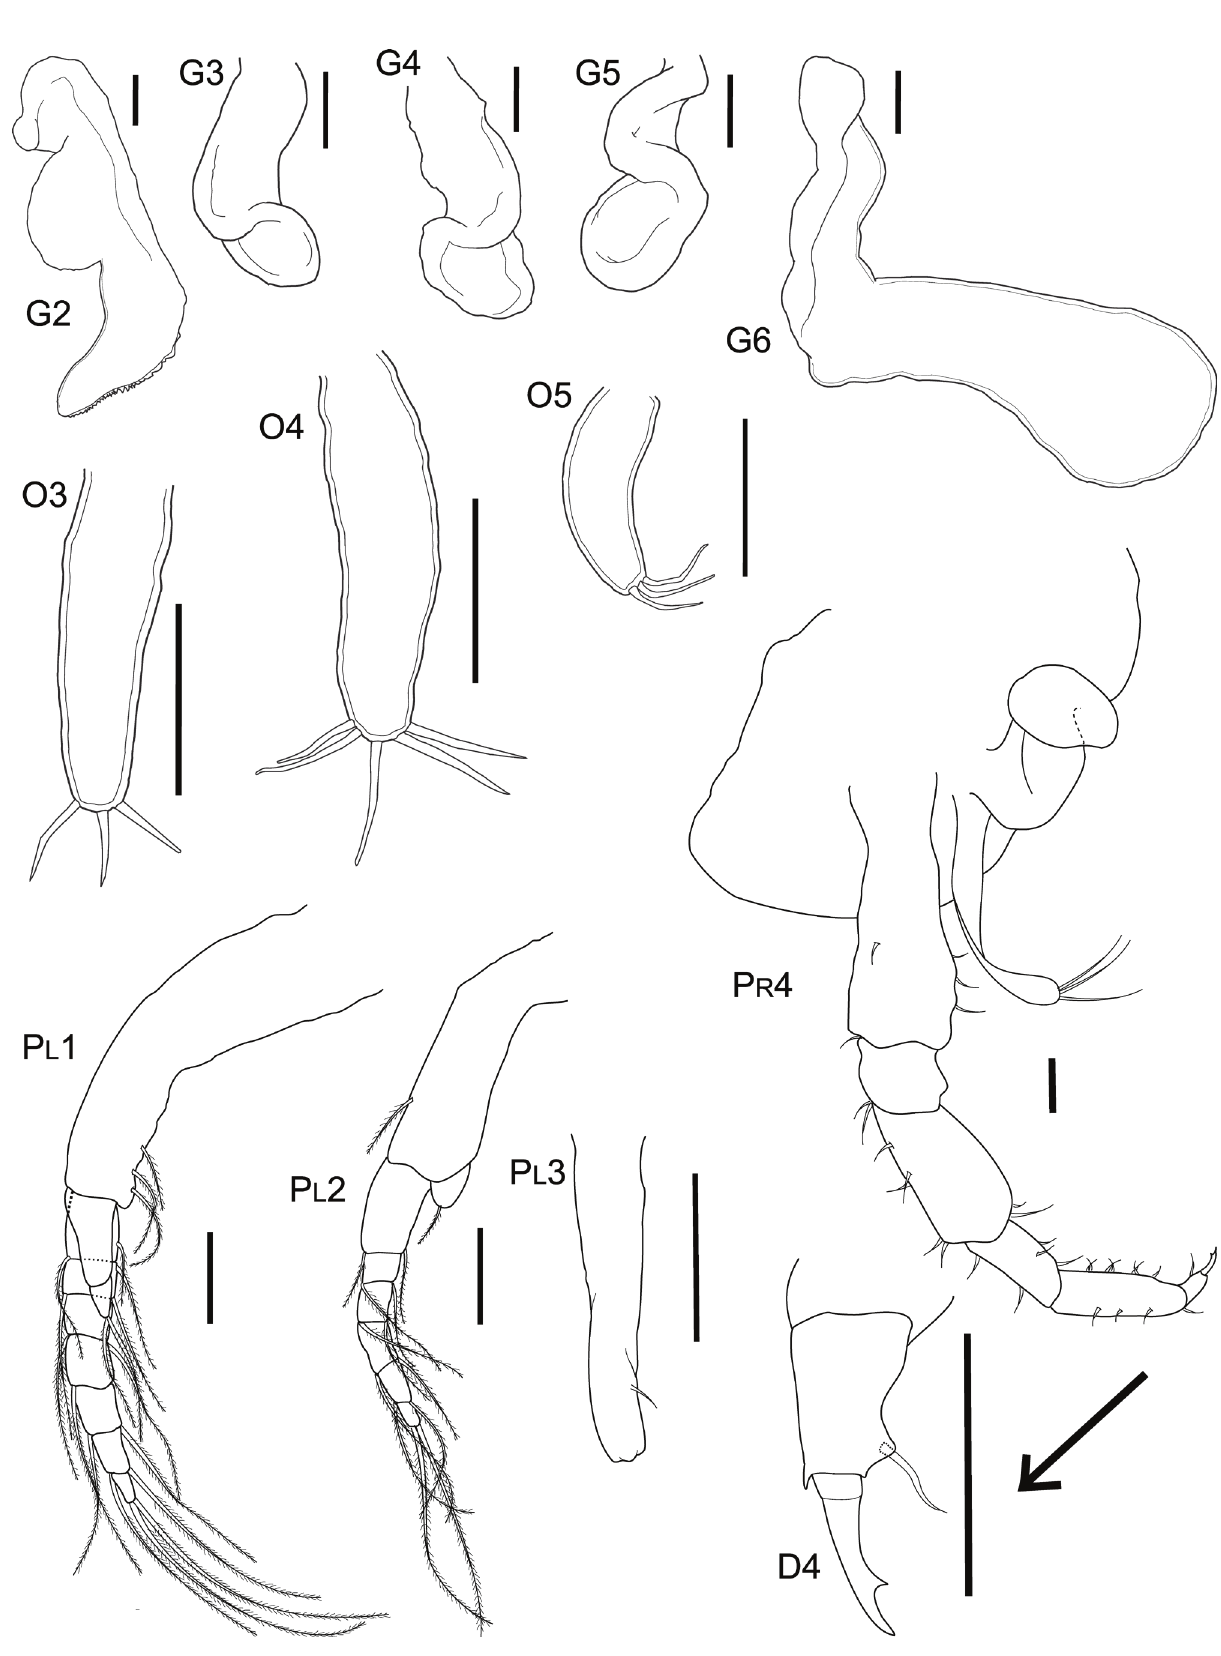
Figure 2. Talitroides alluaudi (Chevreux, 1896). Female 6.2 mm, MNRJ 9717: Gills and oostegites; Female, 5.7 mm, MNRJ 9717: Pleopods and pereopod 4. Scales = 0.1